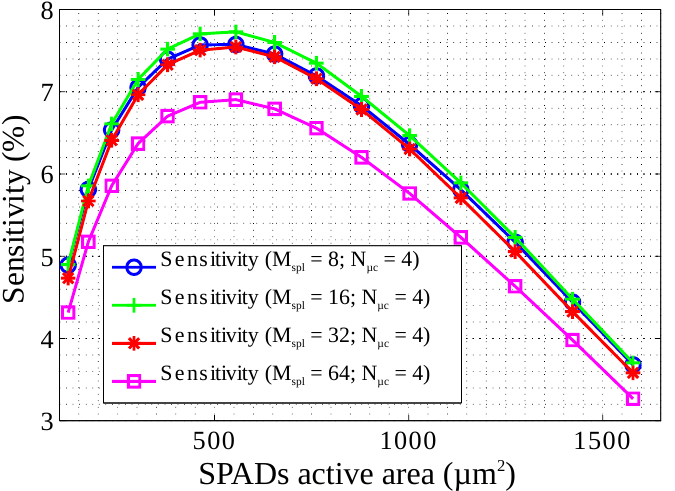
Figure 8. Calculated sensitivity as a function of SPAD active area for a pixel of 1mm 2 . The values were obtained from Equation (5), Table 1, and Figure 6.